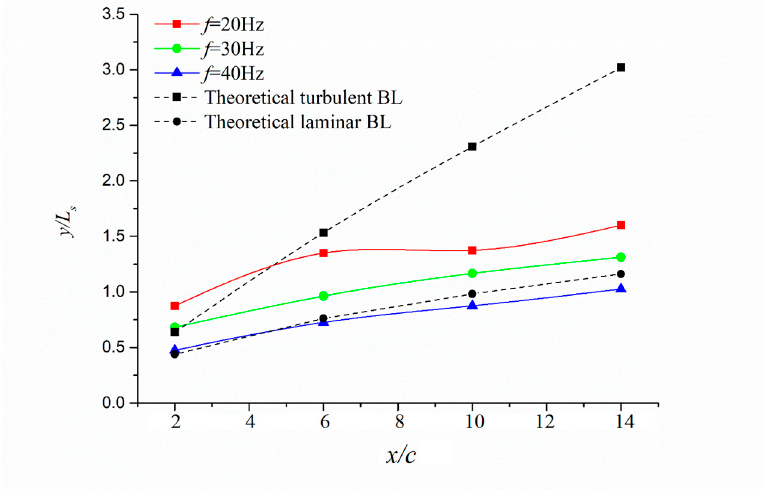
Figure 7. Comparisons of boundary layer calculated by different rotor-stator interaction frequency.